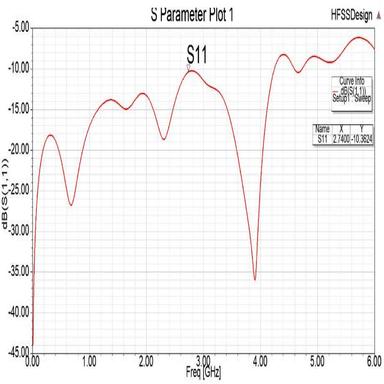
S11 simulation results of a single microstrip antenna fixture as proposed.